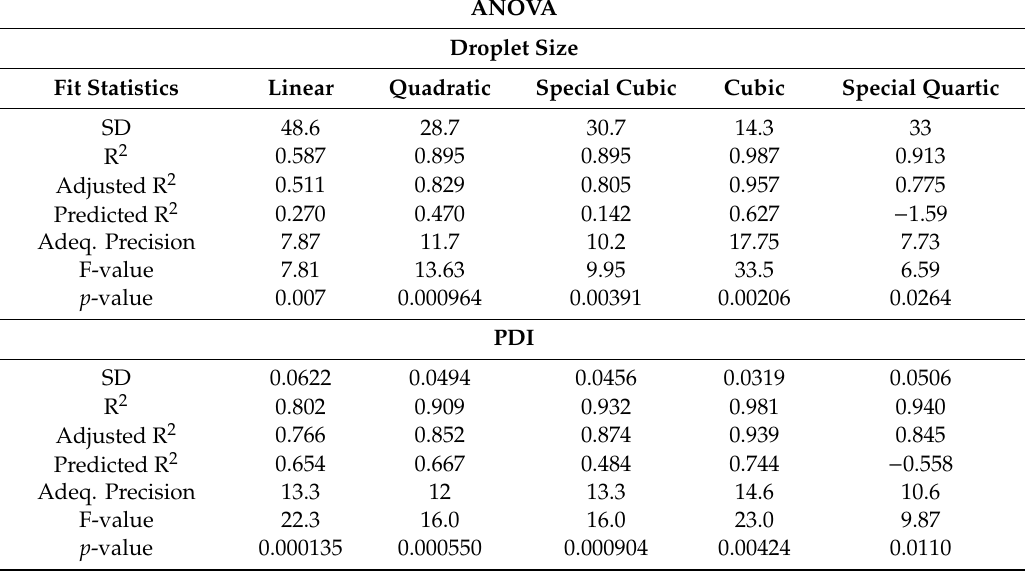
Table 3. Selection of the cubic